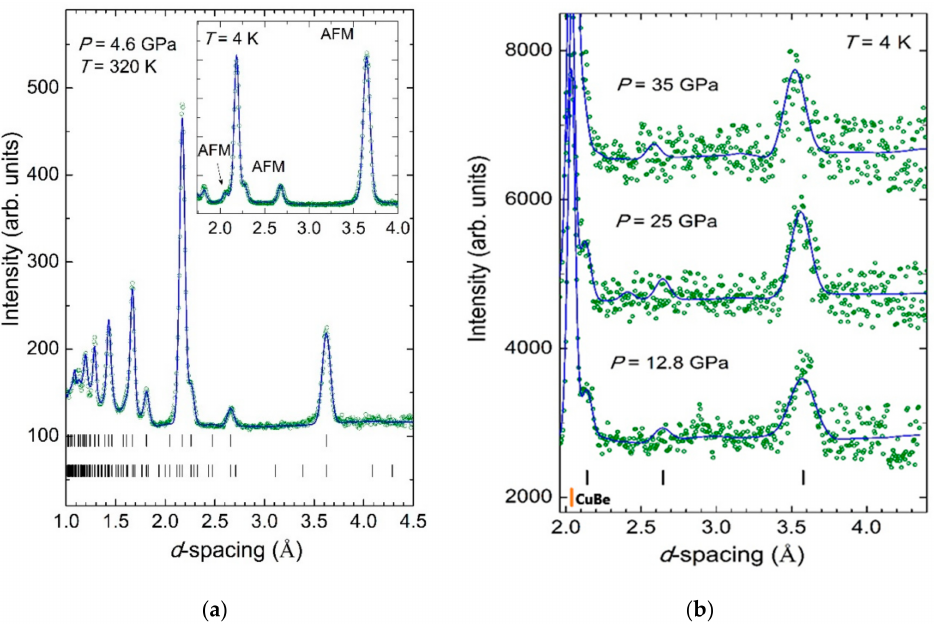
Figure 5. The neutron diffraction patterns of Cr 2 O 3 , measured at P = 4.6 GPa, T = 320 and 4 K in sapphire anvil cell ( a ) and measured at P = 12.8, 25 and 35 GPa and T = 4 K in the diamond anvil cell ( b ), fitted by the Rietveld method. The experimental points and calculated profiles are shown. The ticks below represent the calculated positions of the nuclear peaks (upper row) and magnetic peaks (lower row). In the right panel, the positions of the nuclear and magnetic peaks coincide. In addition, a peak position for the CuBe gasket is also